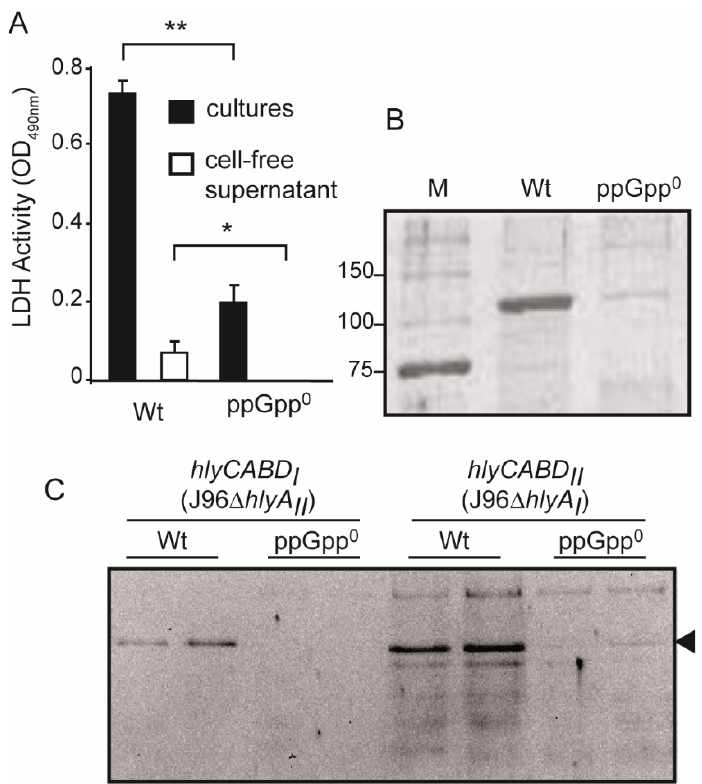
Figure 6. The UPEC-induced cytotoxicity on bladder epithelial cells is reduced in ppGpp-deficient derivatives by affecting production of α -hemolysin. ( A ) Bacterial-induced cytotoxicity on T24 bladder epithelial cells was monitored as lactate dehydrogenase (LDH) activity released (OD 490nm ) after 3 h incubation with bacterial cultures (black bars) or cell-free supernatants (white bars). Bacterial cultures of the UPEC isolate J96 and its ppGpp-deficient derivative (J96 r elA spoT , ppGpp 0 ) were grown in LB at 37 °C up to late exponential phase (OD 600nm of 0.8). The results are mean and standard deviation of four independent determinations. Statistical significance levels are reported as: * = p < 0.05; ** = p < 0.005. ( B ) Coomassie blue stained 12.5% SDS-PAGE analyses of cell-free supernatants from cultures used in A. Lane M: molecular mass markers (size in kDa indicated along the left side). ( C ) The expression of the two hemolytic operons, hlyCABD I and hlyCABD II , present in the J96 strain is stimulated by ppGpp. Immunodetection of the secreted α -hemolysin from cell-free supernatants of cultures of Wt and ppGpp 0 derivatives of J96 Δ hlyA II (JFV16 and JFV18) and J96 Δ hlyA I (JFV21 and JFV22) grown in LB at 37 °C up to an OD 600nm of 0.8. The band corresponding to the α -hemolysin is indicated by an arrowhead.